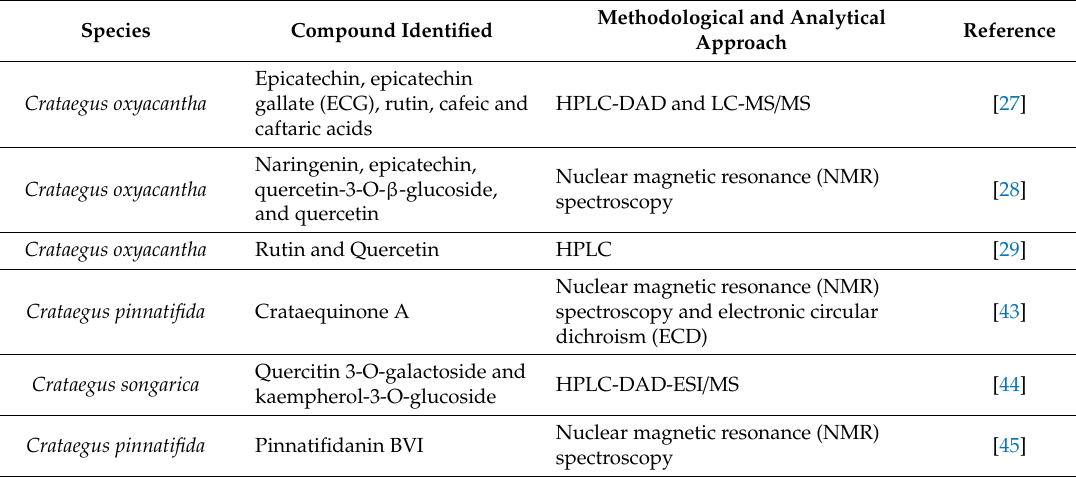
Table 1. Identified compounds from